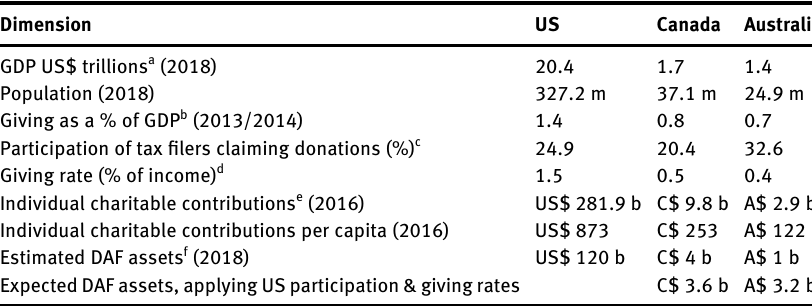
Table  : Comparisons of giving and DAF assets: US, Canada and Australia. Dimension US Canada